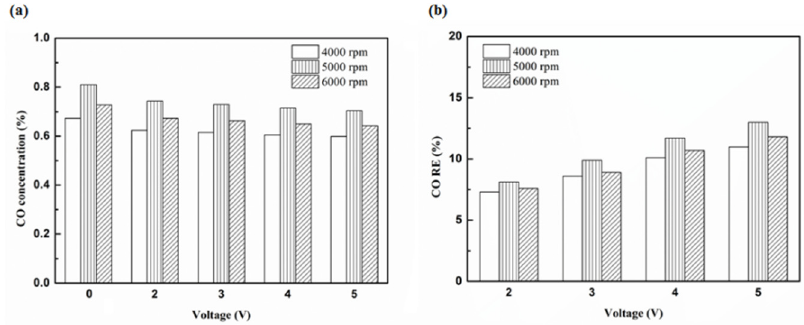
Figure 14. The CO ( a ) emission values and ( b ) RE using platinum in the rear of the exhaust pipe.